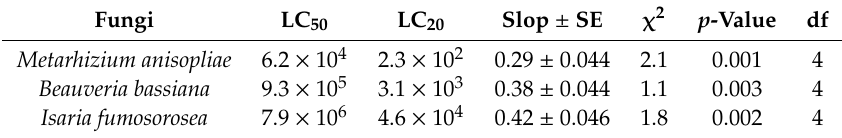
Table 2. Lethal and sublethal concentrations of fungi against Plutella xylostella.